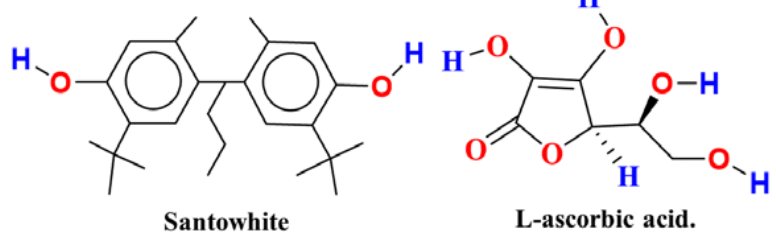
Figure 1. 2D chemical structure of Santowhite and L-ascorbic Figure 1 . 2D chemical structure of Santowhite and L-ascorbic acid.